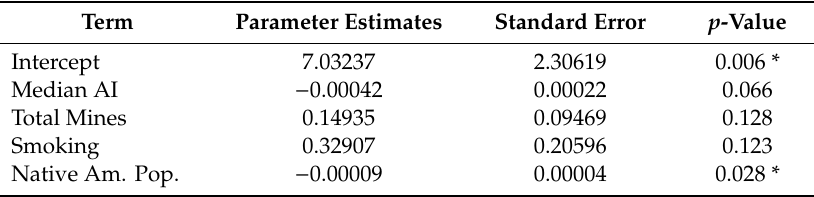
Table 3. Regression results for AAP (R 2 =